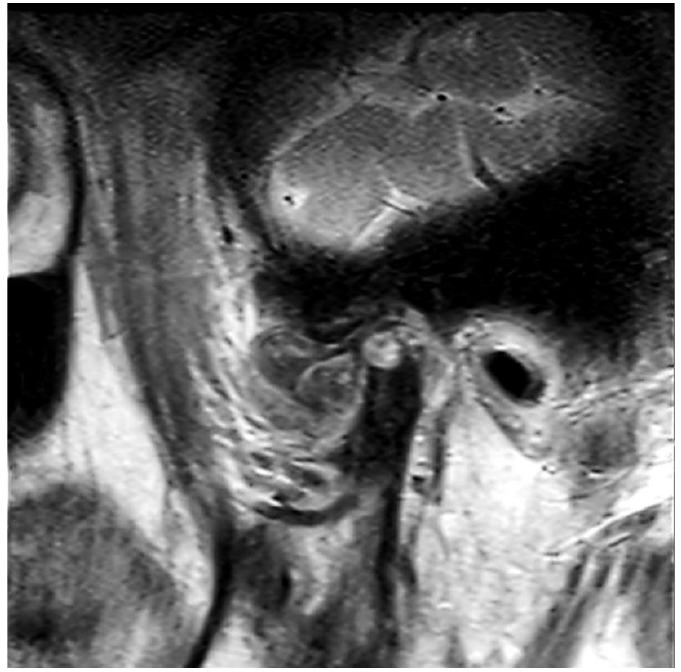
Figure 3. Magnetic resonance image. Proton density-weighted image of the sagittal plane.